Question: Which kind of chart has been used to present this data?
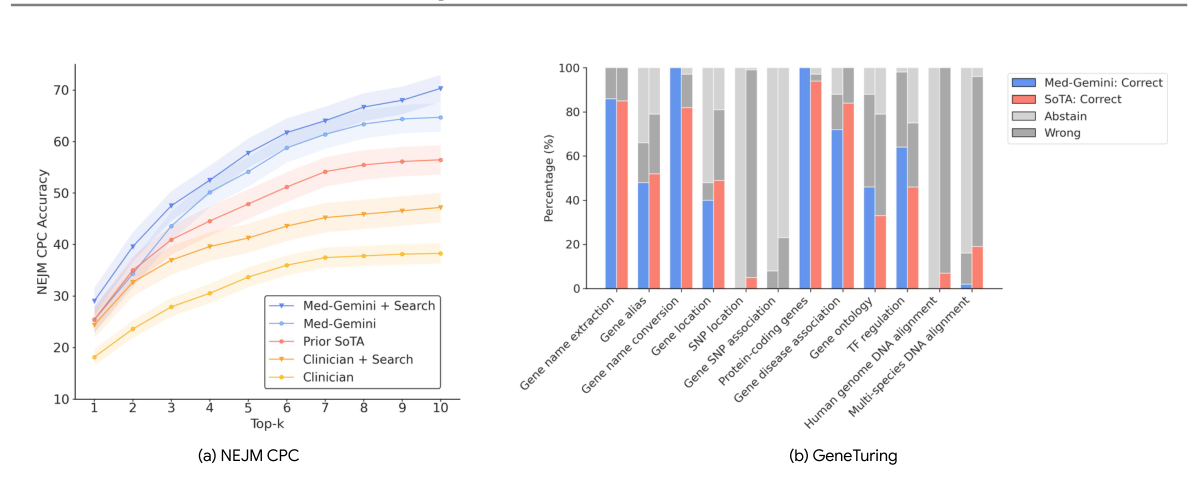
Answer: bar